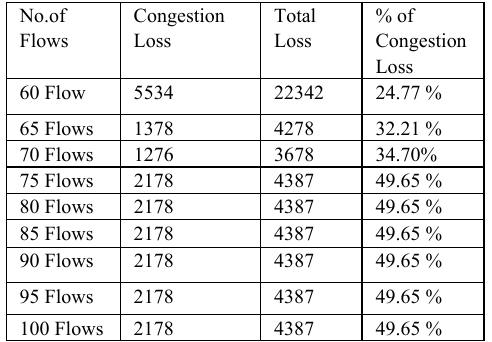
Table 4. Congestion loss ratio for TCP (Speed 30 m/s)